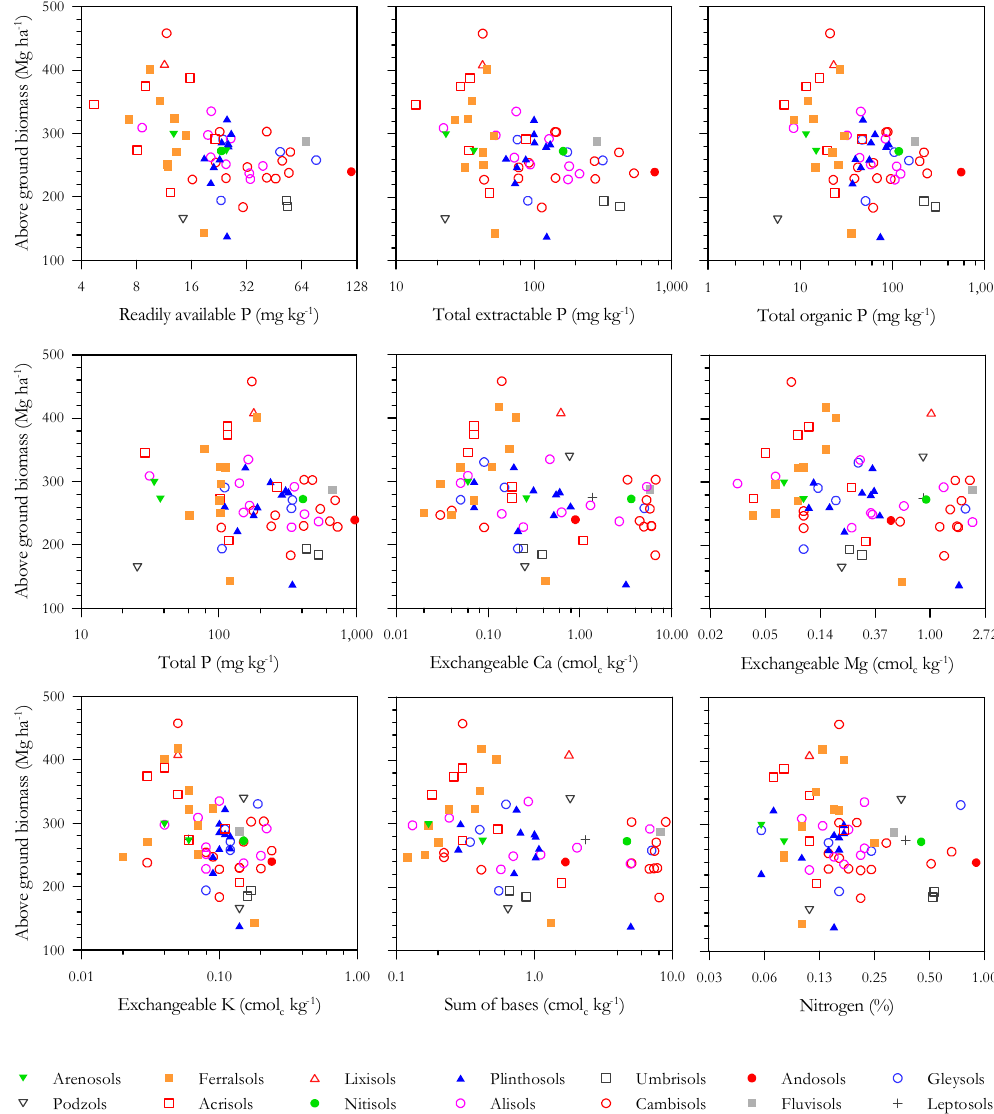
Fig. 12. Relationships between above-ground biomass and different soil fertility